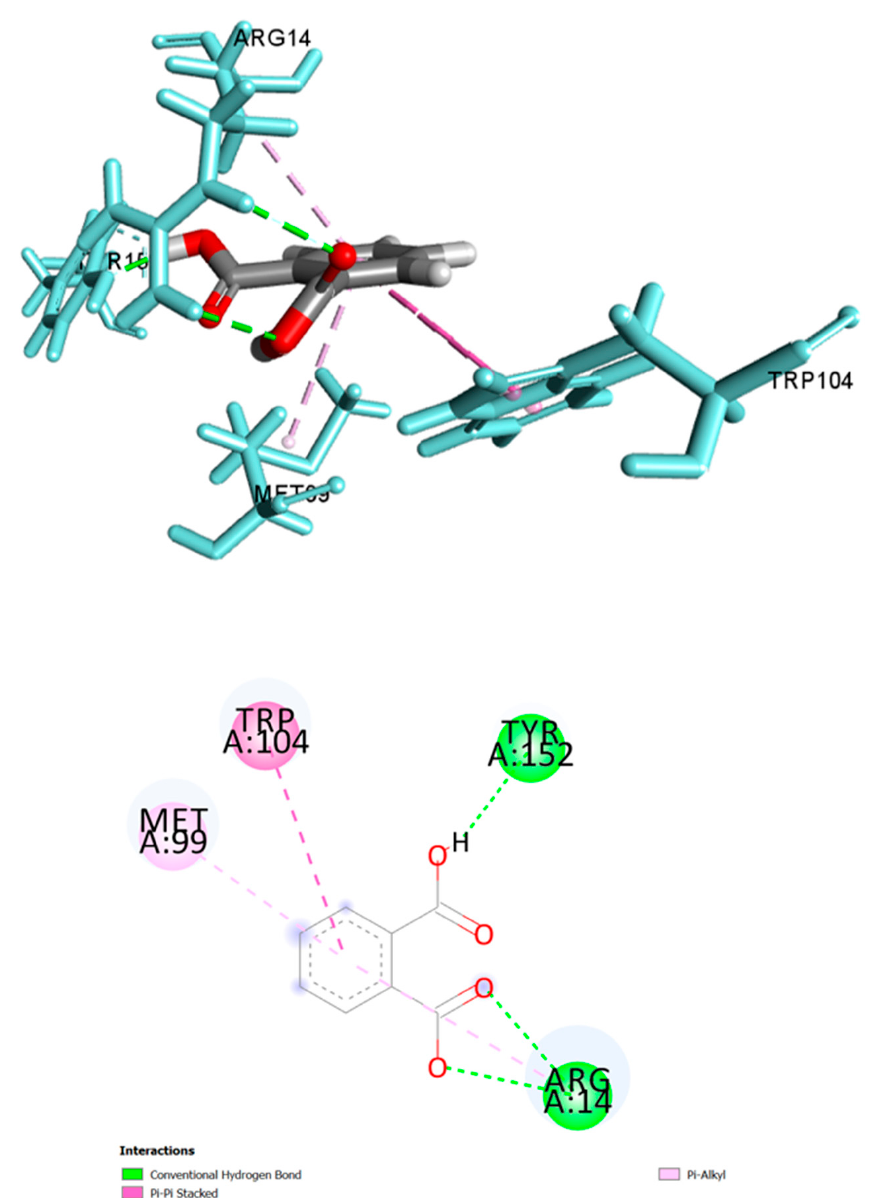
Figure 5. Molecular docking study of L. indica phytochemicals. ( A ) Docked pose of phthalic acid in the PGD 2 synthase binding site showing molecular interactions—hydrogen and hydrophobic bonds as green and pink/purple dashed lines, respectively; ( B ) 2D plot of interactions between phthalic acid and key residues of PGD 2 synthase generated by BIOVIA Discovery Studio visual- izer.